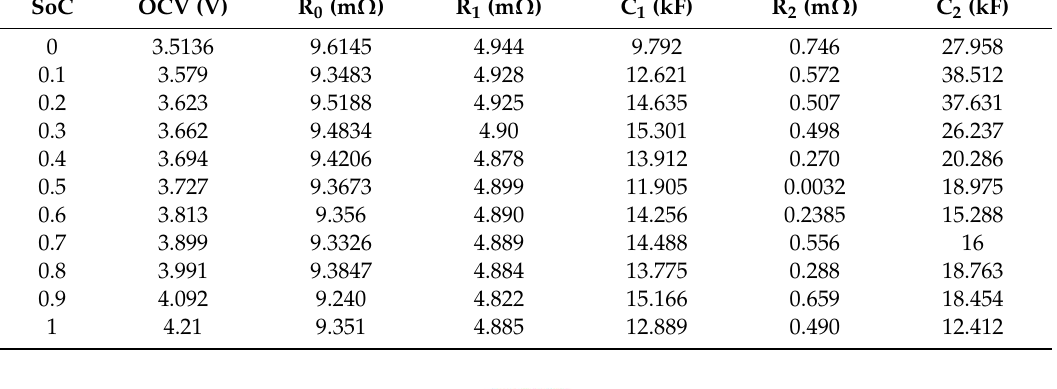
Table 2. Battery model parameters for Li-ion NMC cell at T = 20 ◦ C.